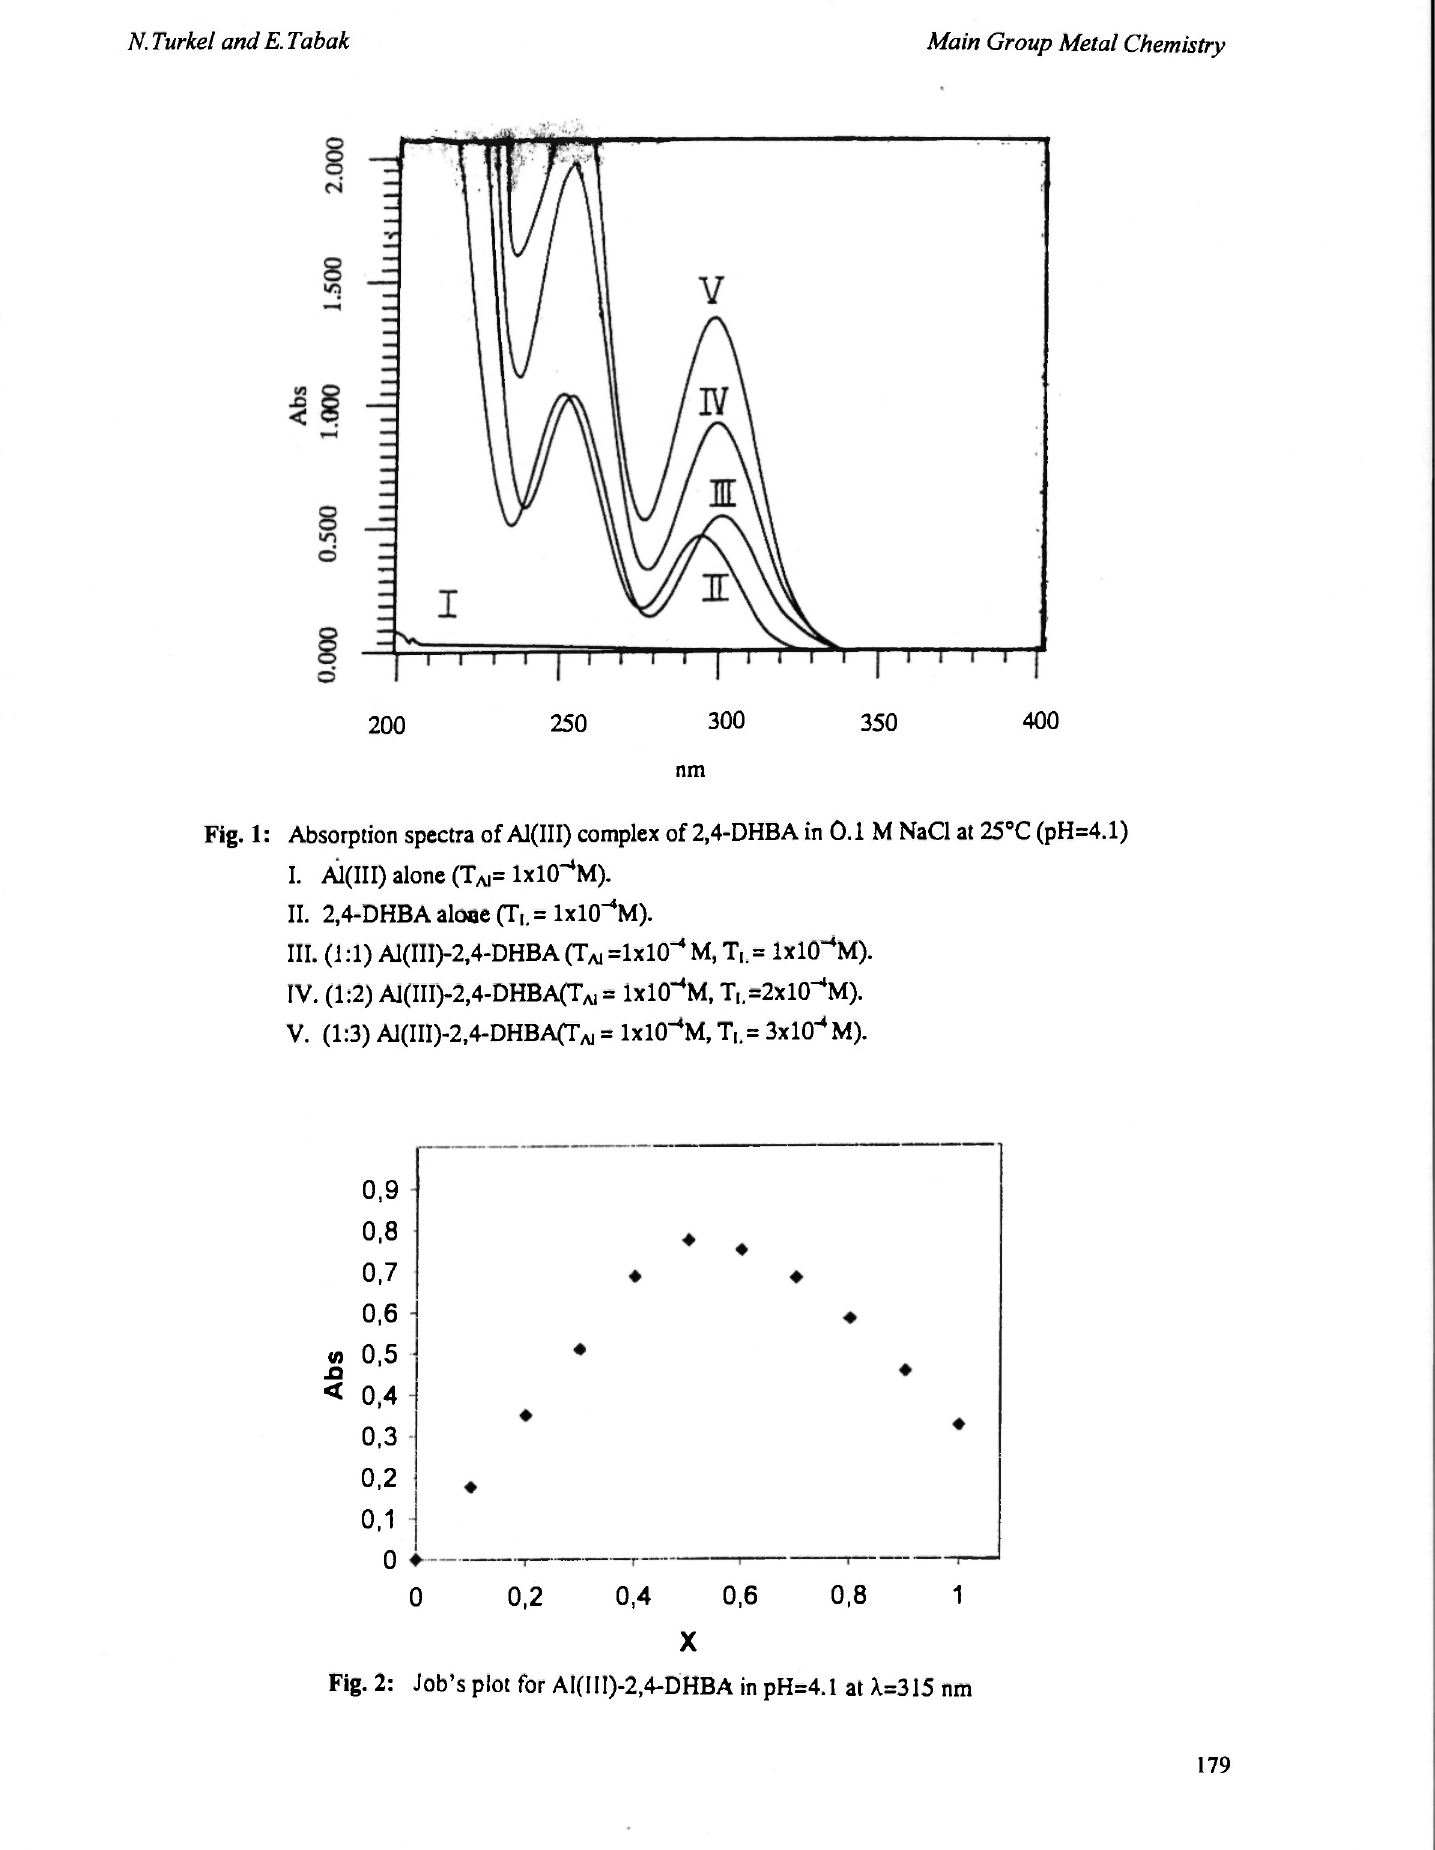
Fig. 2: Job's plot for AI(III)-2,4-DHBA in pH=4.1 at λ=315